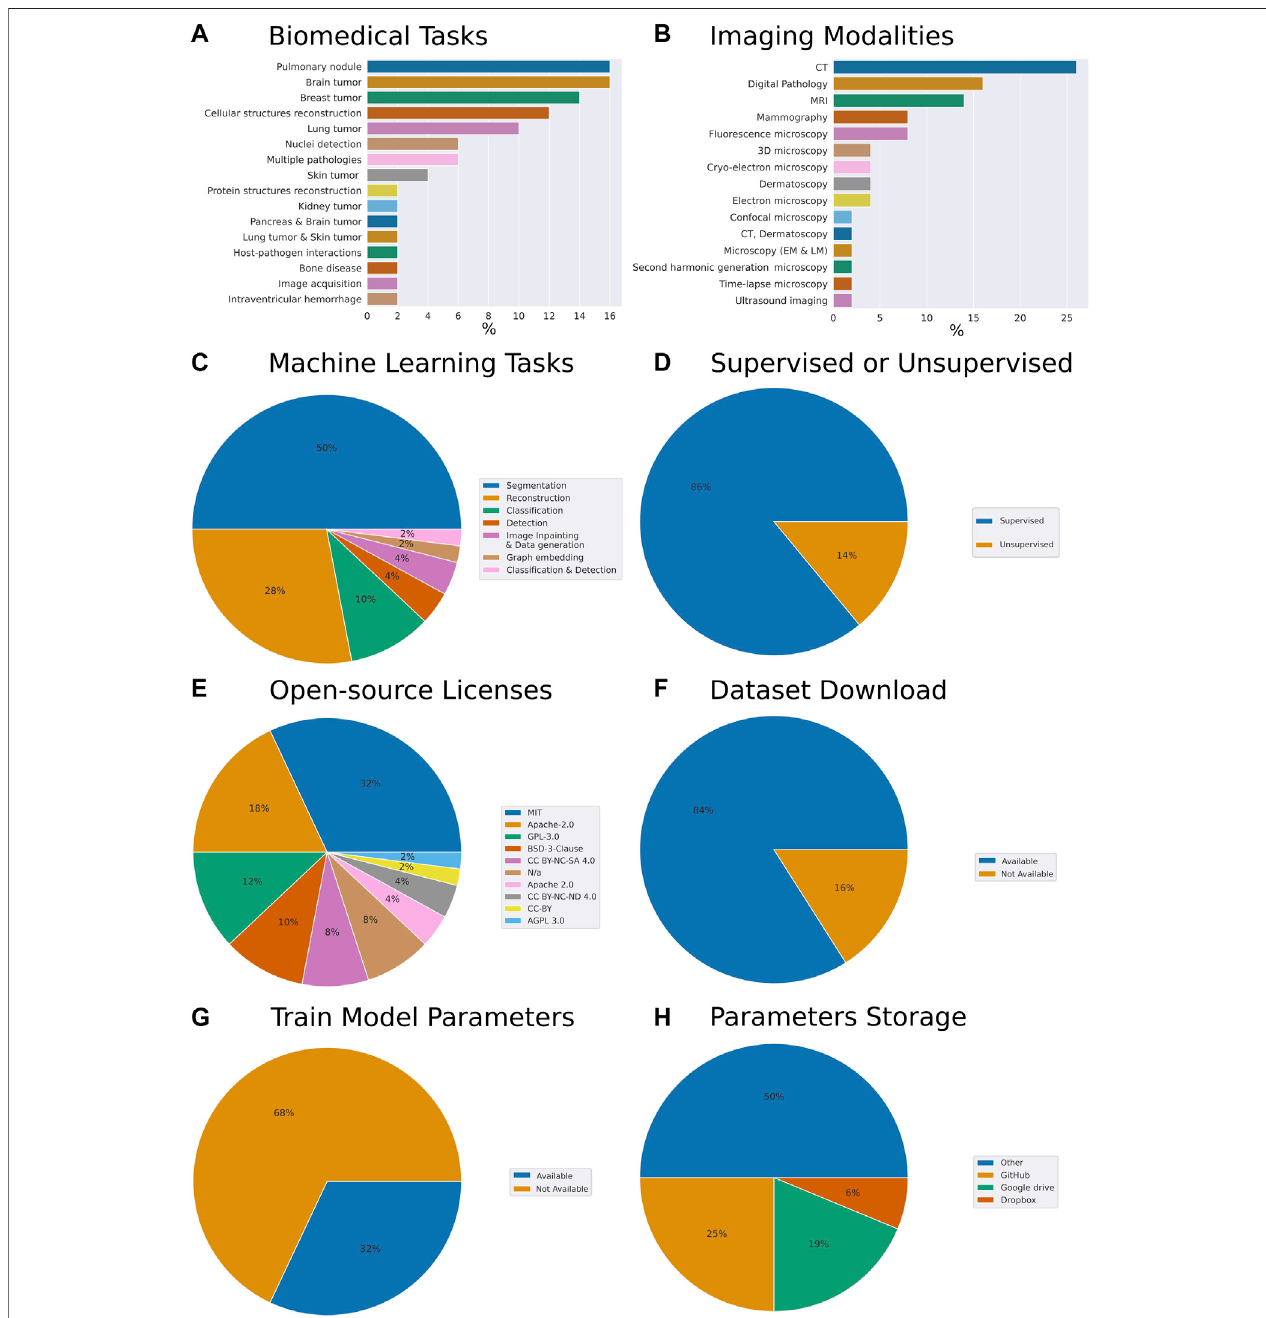
FIGURE1| Meta-analysisoftrendsinopen-sourcebiomedicalimageanalysismodels (A) Biomedicaltasksoverviewandbreakdowninourcollection (B) Varietyof imaging modalities (C) Machine learning tasks the models are aimed at (D) Are the ML algorithms used for supervised or unsupervised learning tasks (E) Prevalence of open sourcelicensesused (F) Availabilityofdatasets (G) Availabilityoftrainedmodelparameters (H) Prevalenceofplatformsused fortrainedmodelparameters sharing. Here, CT is computed tomography, MRI is magnetic resonance imaging.